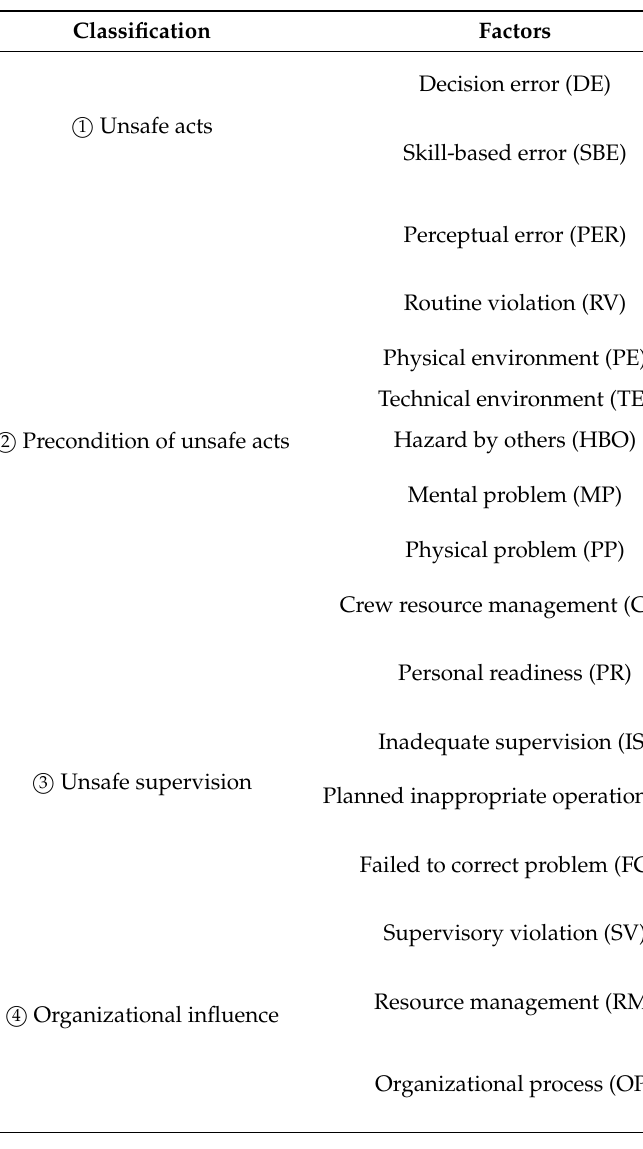
Table 1. The modified HFACS used in this